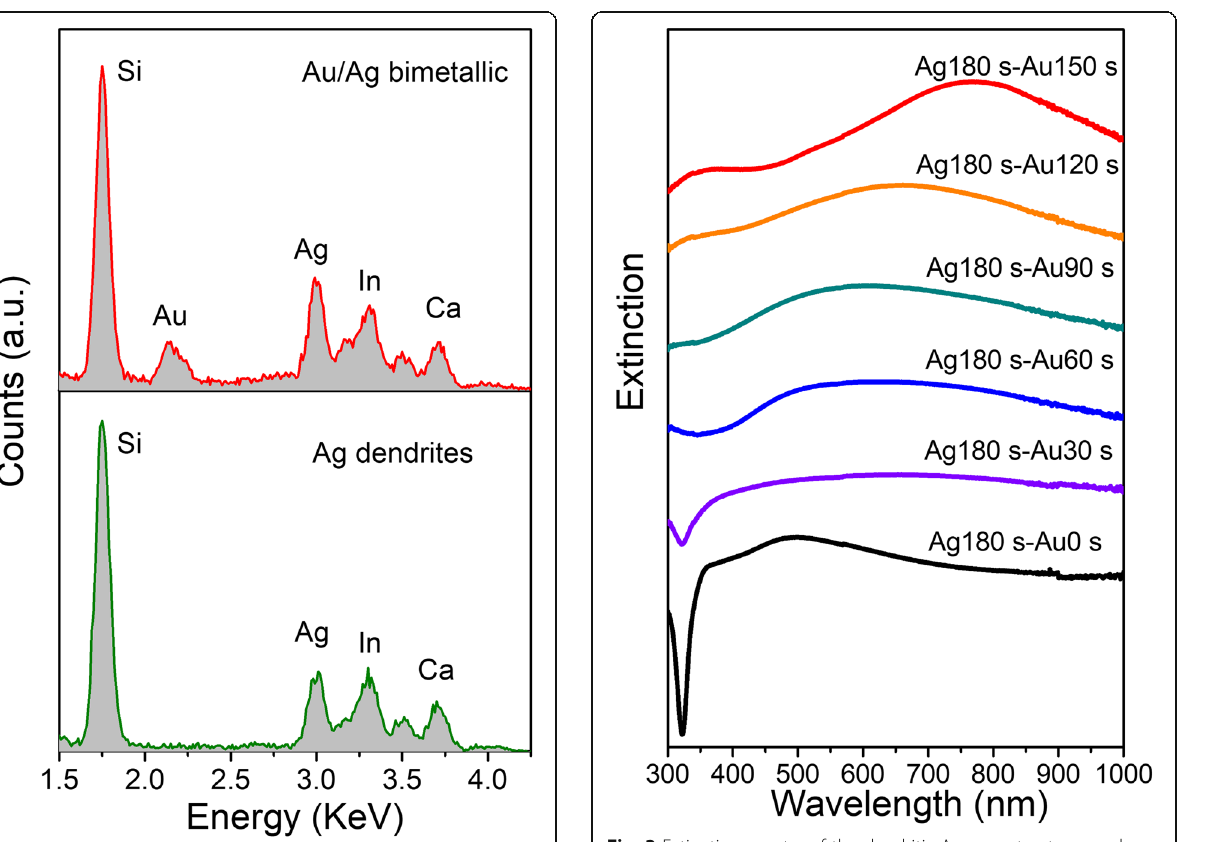
Fig. 2 EDX spectra of the dendritic Ag nanostructures (Ag180s-Au0s) and dendritic Au/Ag bimetallic nanostructures (Ag180s-Au30s)